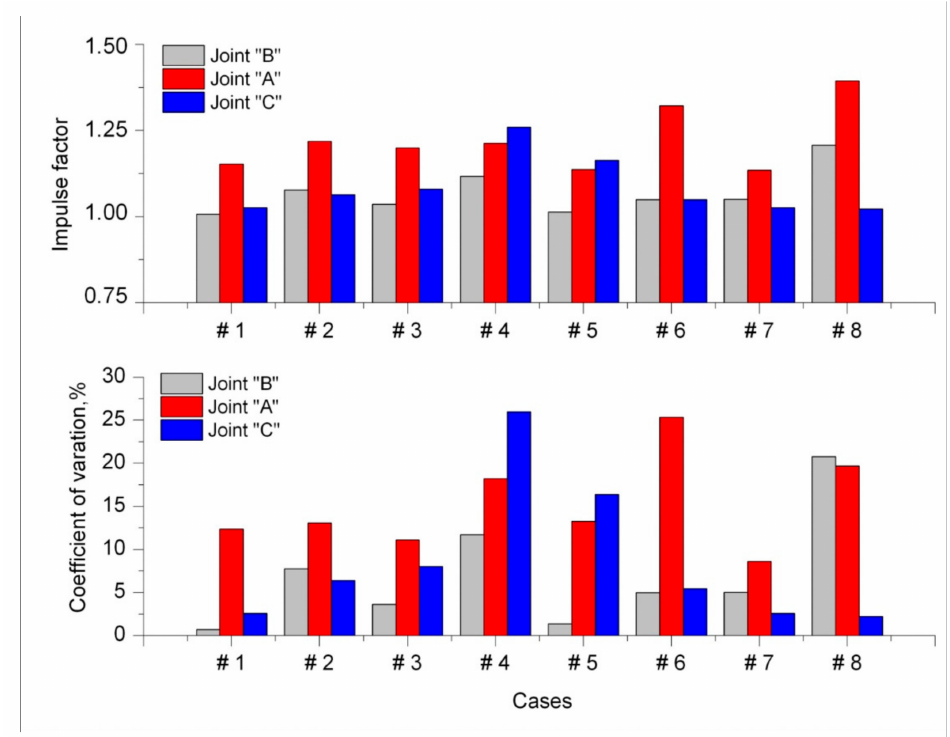
Figure 19. Diagnostic factors of balance levers in the wheeled bogies for case #1 to case #8 of non-uniform strain